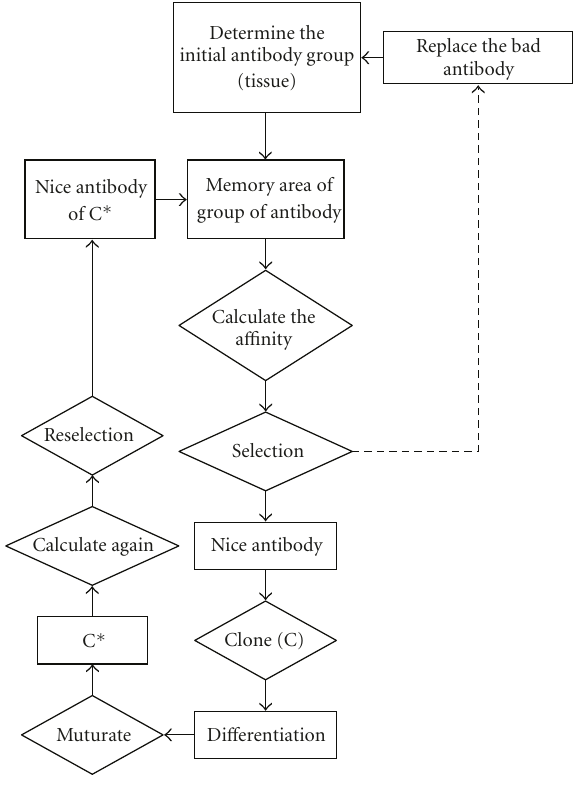
Figure 6: Experiment flow